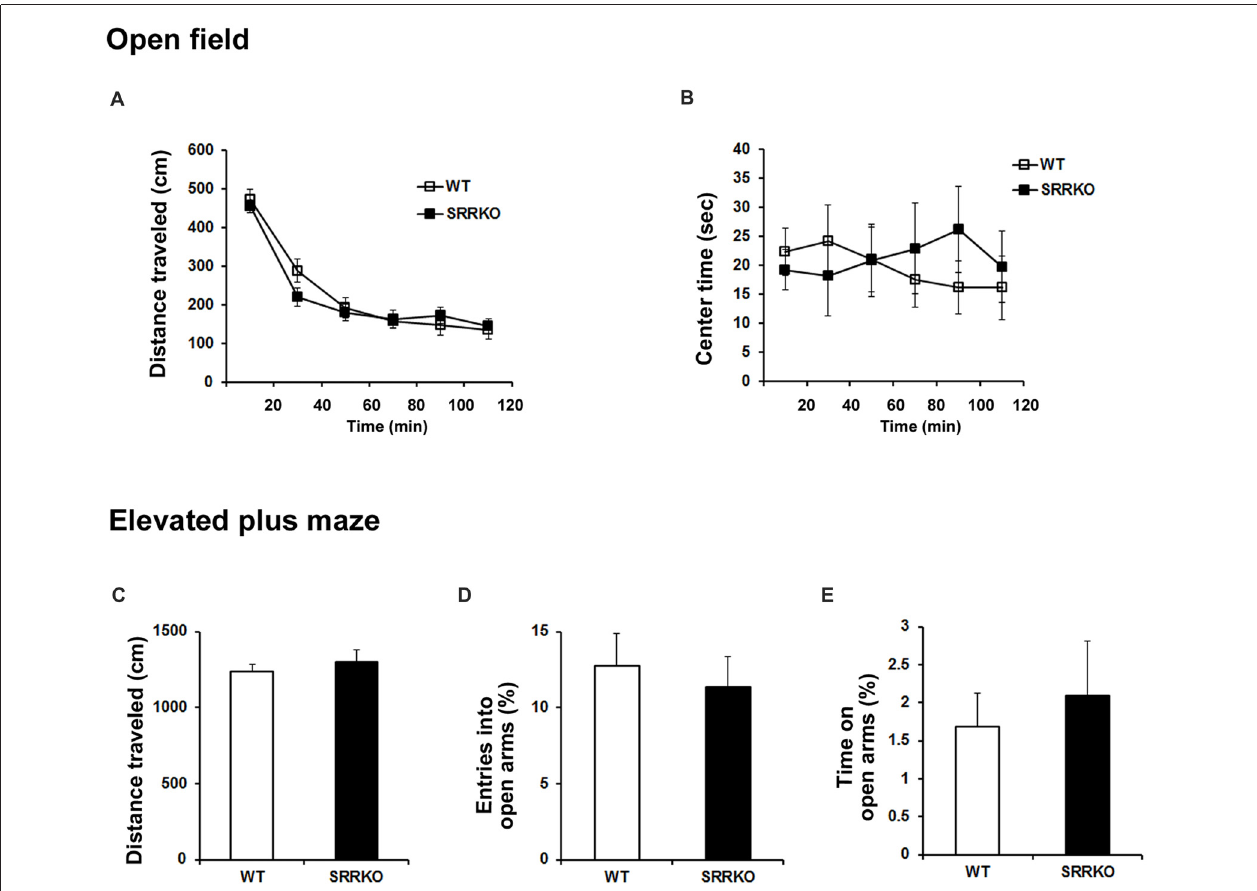
FIGURE 4 | SRRKO mice exhibit no changes in locomotor activity and anxiety level compared with WT mice. (A,B) In the open field test, the distance of travel throughout the apparatus (A) and the time spent in the center zone of the open field (B) were comparable between WT and SRRKO mice ( n = 20). (C–E) In the elevated plus maze test, there were no significant differences in the distance of travel throughout the apparatus (C) , the percentage of entries into (D) and the time spent in the open arms (E) between the two genotypes. Data are presented as mean ± SEM.